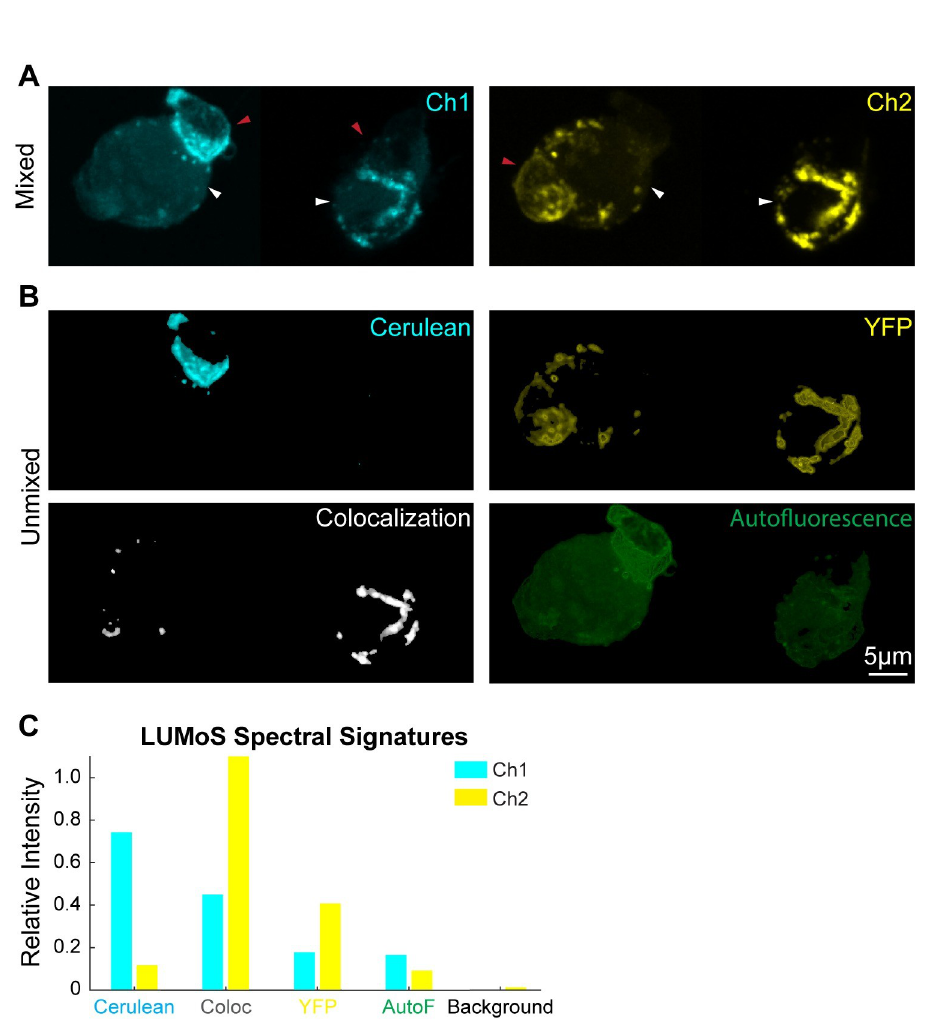
Fig 6. LUMoS unmixing for colocalization analysis and autofluorescence removal. (A) The raw 2-channel 2PLSM images of T cells expressing Cerulean, YFP, or colocalized Cerulean and YFP. APCs are larger cells (pointed out by white arrows) than T cells (pointed out by red arrows), and APCs are non-labeled but autofluorescent. The fluorophores were concentrated at the conjugation sites between T cells and APCs. The images were z-projections of slices 6 to 17 of 3D z-stack images (S3 Movie). The left and right cells were imaged by two acquisitions and stitched, but with the same imaging conditions. (B) LUMoS separation results of the images in A. Autofluorescence and colocalization were split into separate channels while keeping pure Cerulean and YFP signals in their own channels. Signals from background pixels were separated and removed (S3D Fig). (C) The spectral signatures of each structures produced by LUMoS. Background and autofluorescence (AutoF) were identified as additional pixel groups with distinct signatures. Colocalization (Coloc) spots were separated out due to its different spectral signature from the Cerulean-only and YFP-only groups.